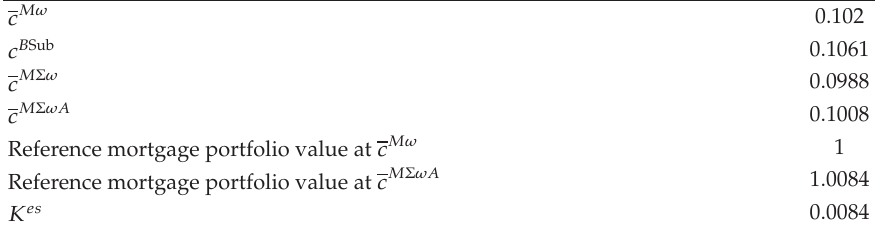
Table 6: Costs and benefits from mortgage securitization.